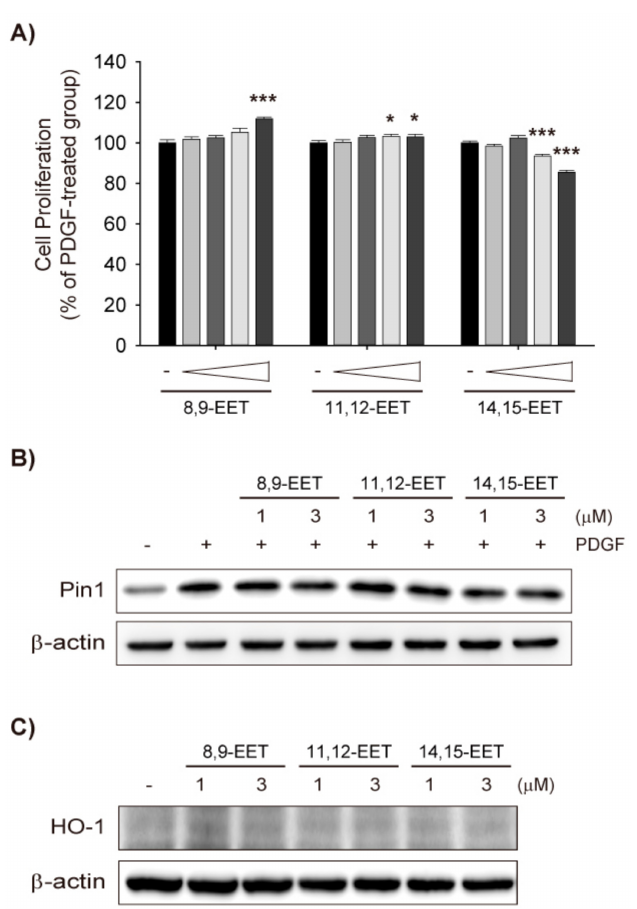
Figure 2. Exogenous epoxyeicosatrenoic acids (EETs) do not inhibit VSMC proliferation nor affect Pin1 and HO-1 expression. ( A ) Effects of EETs on VSMC proliferation. Rat VSMCs were preincubated with vehicle control, 8,9-EET, 11,12-EET, or 14,15-EET (0.1–3 µ M) for 30 min and exposed to